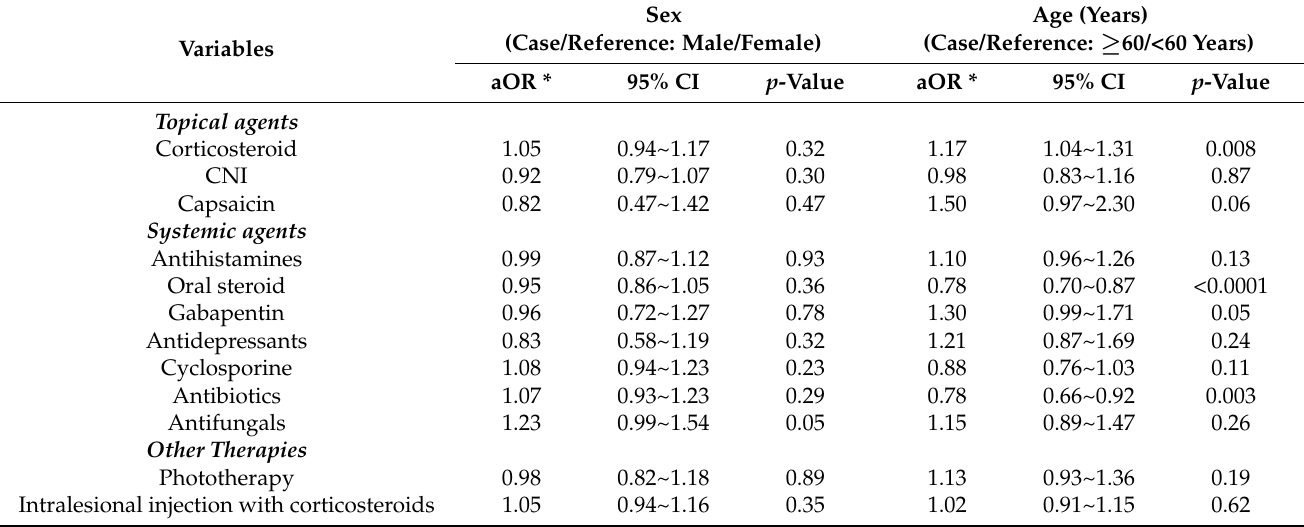
Table 5. Prescription patterns for